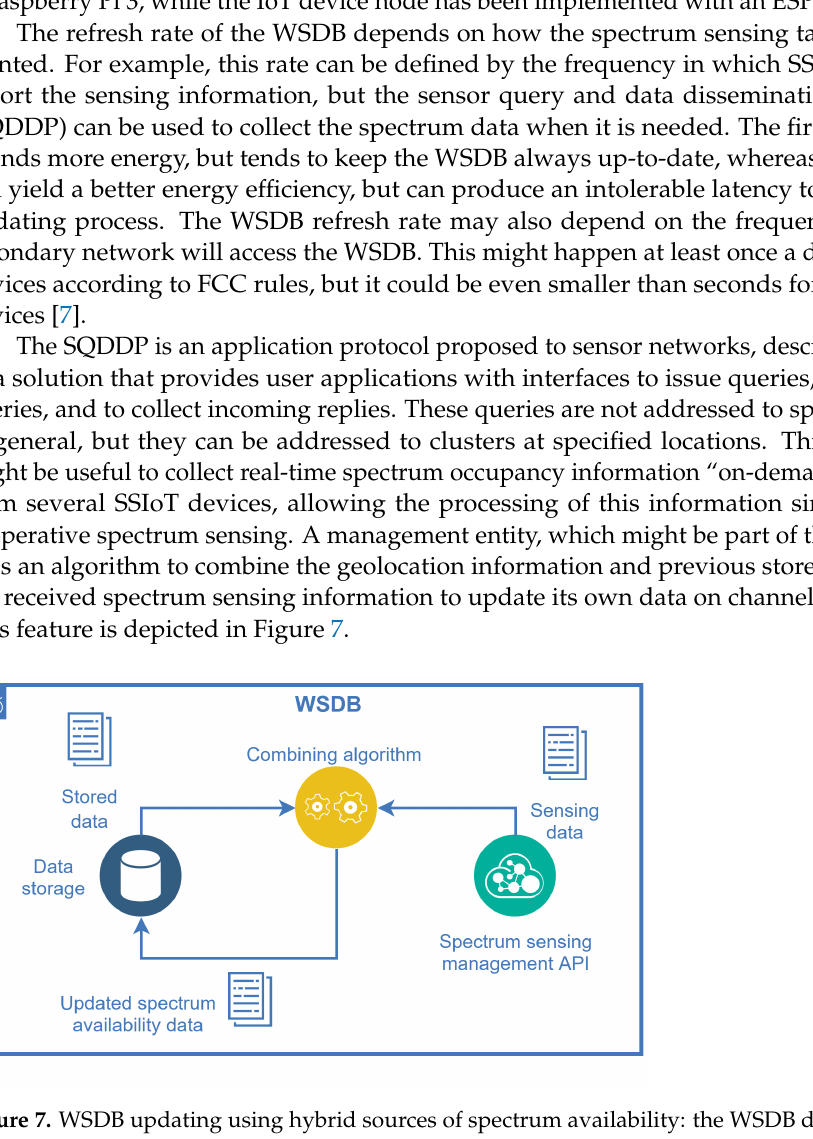
Figure 7. WSDB updating using hybrid sources of spectrum availability: the WSDB data itself and the spectrum sensing information coming from SSIoT